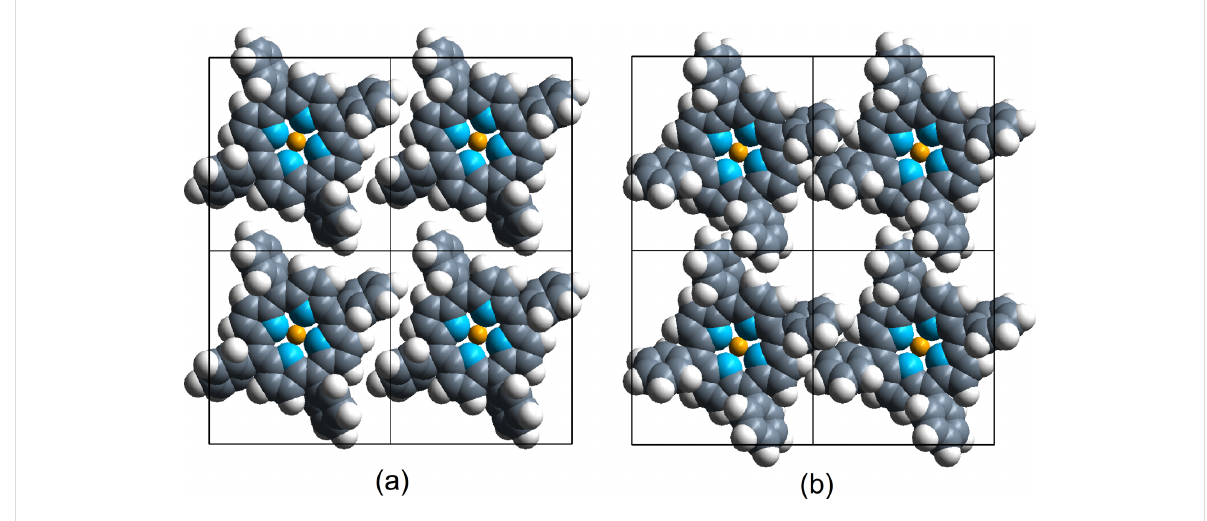
Figure 3: a) T-type (saddle conformation) and b) π – π -type (deckchair conformation) arrangements of FeTPP in 2D assemblies.